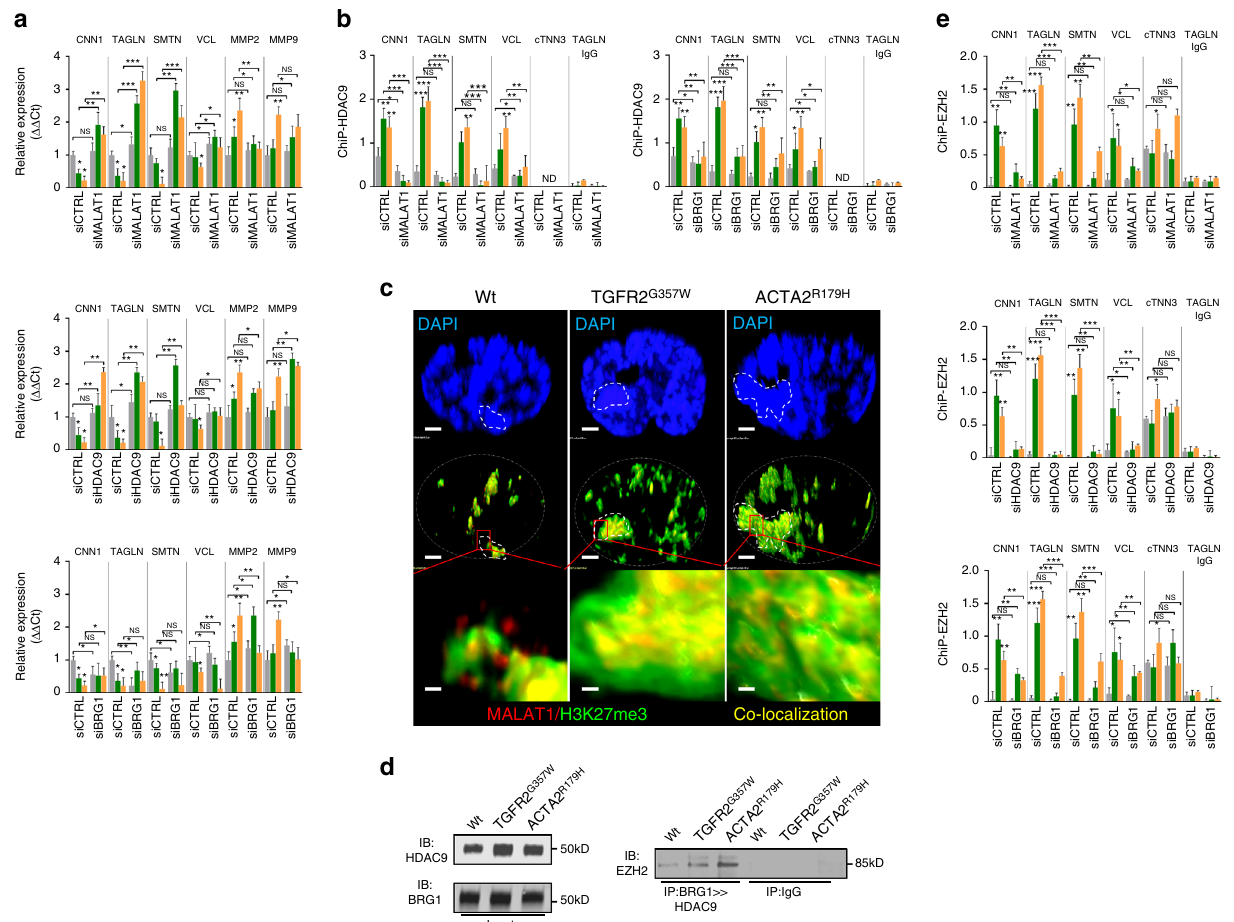
Fig. 5 HDAC9 – MALAT1 – BRG11 is required for EZH2 recruitment to chromatin. a Qualitative PCR analysis of synthetic and contractile genes demonstrate HDAC9 and MALAT1-dependant repression in TGFR2 G357W or ACTA2 R179H expressing VSMCs. b HDAC9 chromatin immunoprecipitation assays (ChIP) demonstrates MALAT1 and BRG1-dependant association with VSMC promoters. c MALAT1 fl uorescence in situ hybridization (FISH) shows colocalization with H3K27me3 marks and areas of dense heterochromatin (dotted line). Bar = 1.2 µ M, top and middle row, Bar = 120 nM, bottom row ( d ) Western blot of ectopically expressed EZH2 demonstrating association with sequential BRG1 and HDAC9 immunoprecipitates in TGFR2 G357W or ACTA2 R179H expressing cells. e Chromatin immunoprecipitation assays (ChIP) demonstrate HDAC9, BRG1, and MALAT1-dependant association of EZH2 with VSMC promoters. (Student ’ s T -test, NS not signi fi cant, * p < 0.05, ** p < 0.01 vs. WT) Bar graphs are presented as mean with error bars (±S.D.), Student ’ s T -test, * p < 0.05, ** p < 0.01 vs. WT. Full-length western blots presented in Supplementary Fig.